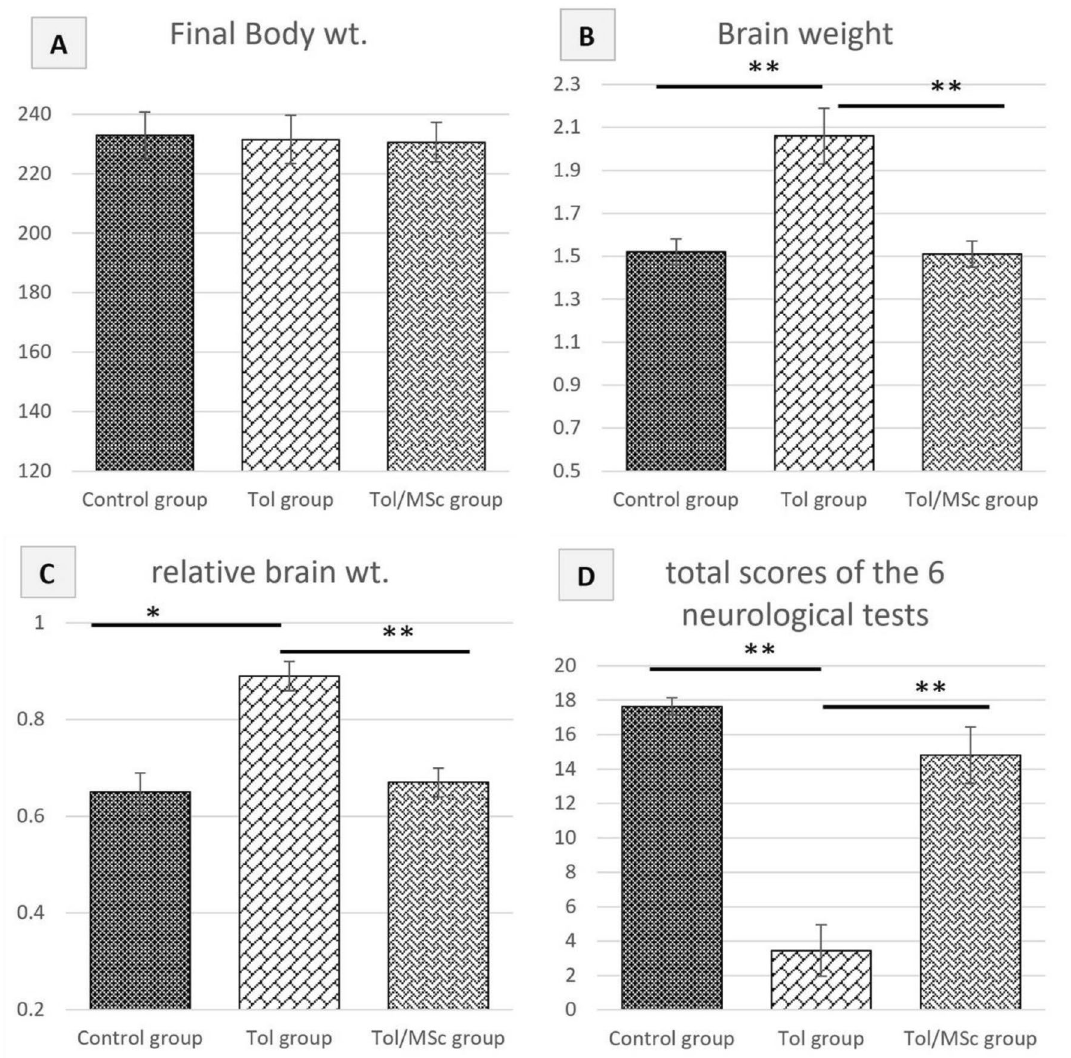
Figure 2. Charts ( A ) rat body weight, ( B ) rat brain weight, ( C ) relative brain weight “brain weight/body weight %” ( C ) total scores of the 6 neurological tests in different studied groups. *significant difference, **highly significant difference.